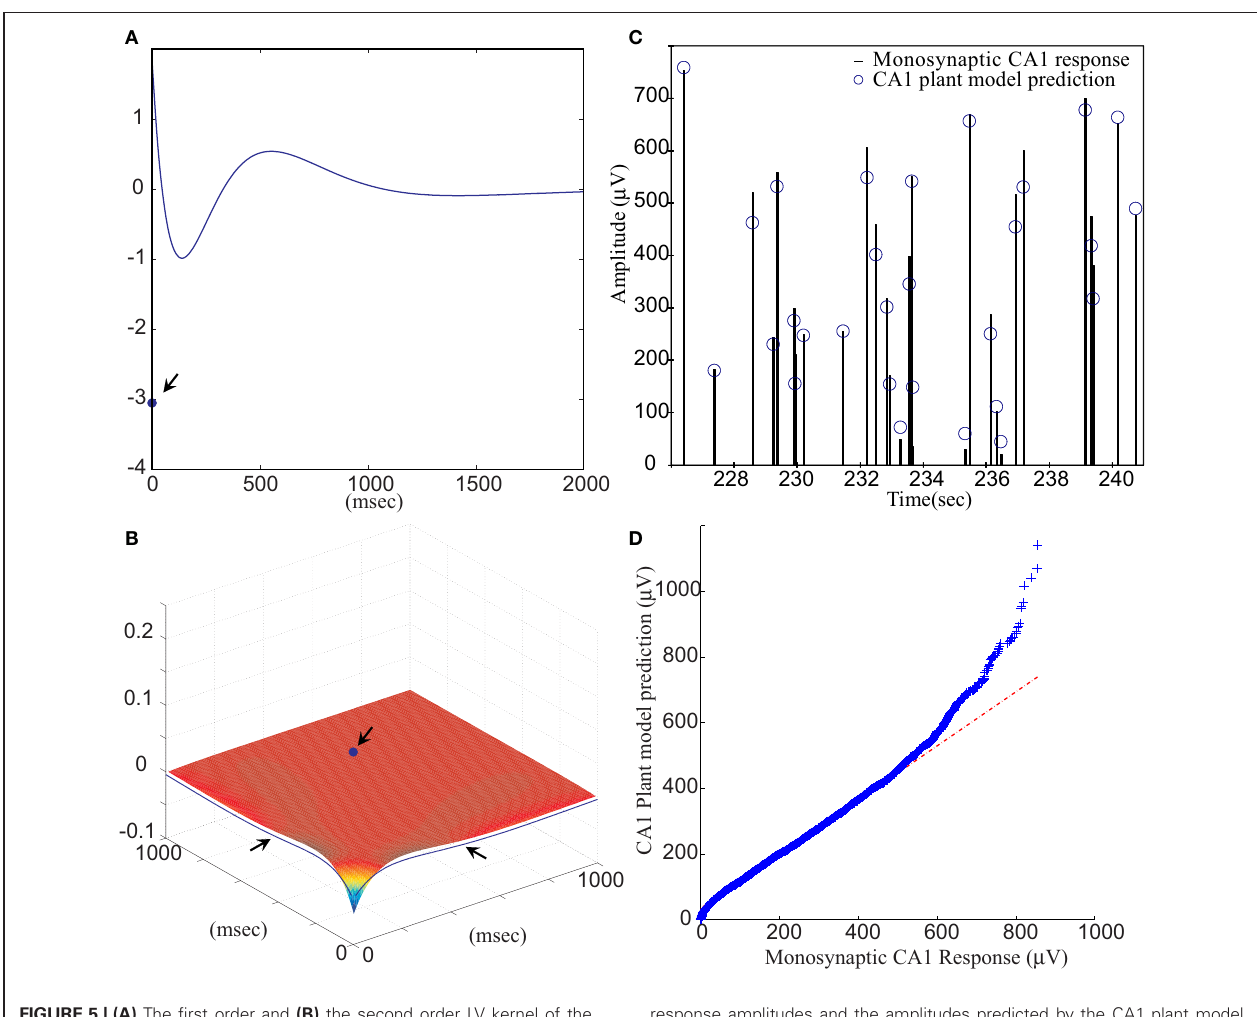
FIGURE 5 | (A) The first order and (B) the second order LV kernel of the CA1 plant model. The singular points and lines showing on the edge of each figure (indicated by arrows) represent the effect of present input. (C) A segment of comparison between RARIT-induced monosynaptic CA1